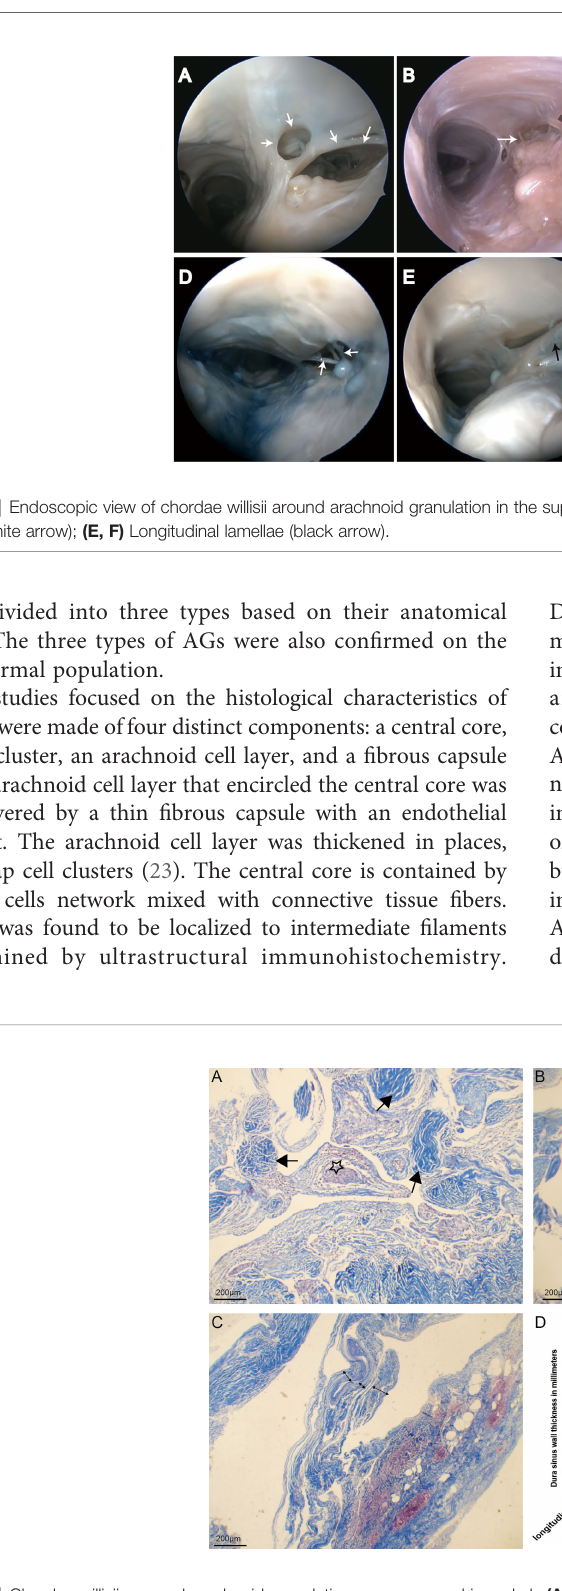
FIGURE 5 | Chordae willisiis around arachnoid granulation were arranged irregularly (A) . Chordae willisiis revealed the presence of one layer (B) , and dura sinus wall with multiple layers (C) . Comparison of thickness of trabecular chordae, longitudinal lamellae, valve-like lamellae and dural sinus wall in the superior sagittal sinus (D)